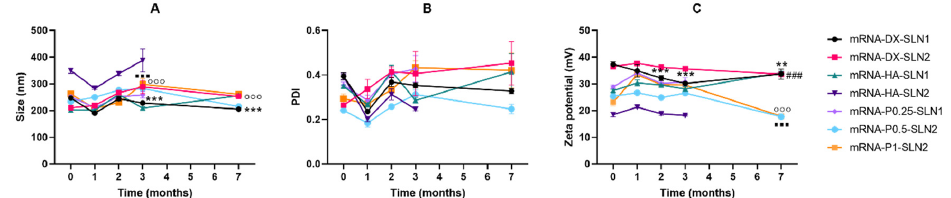
Figure 9. Size ( A ), polydispersity index ( B ) and ζ -potential ( C ) of mRNA-based vectors formulated with SLN1 and SLN2 at time zero and one, two and three months. Data are expressed as mean ± standard deviation; n = 3. ** p < 0.01, *** p < 0.001 with respect to mRNA-DX-SLN1 at time zero. ### p < 0.001 with respect to mRNA-HA-SLN1 at time zero. °°° p < 0.001 with respect to mRNA-P0.5-SLN2 at time zero. ▪▪▪ p < 0.001 with respect to mRNA-P1-SLN2 at time zero. In the case of mRNA formulations, after seven months, the mean size (Figure 9A) changed significantly for mRNA-P0.5-SLN2 and mRNA-DX-SLN1; it decreased 20 and 40 nm, respectively. PDI values were below 0.4 during the stability study (Figure 9B). Differences were observed after two months in ζ -potential for mRNA-DX-SLN1, and at month seven for all formulations except for mRNA-DX-SLN2 (Figure 9C).